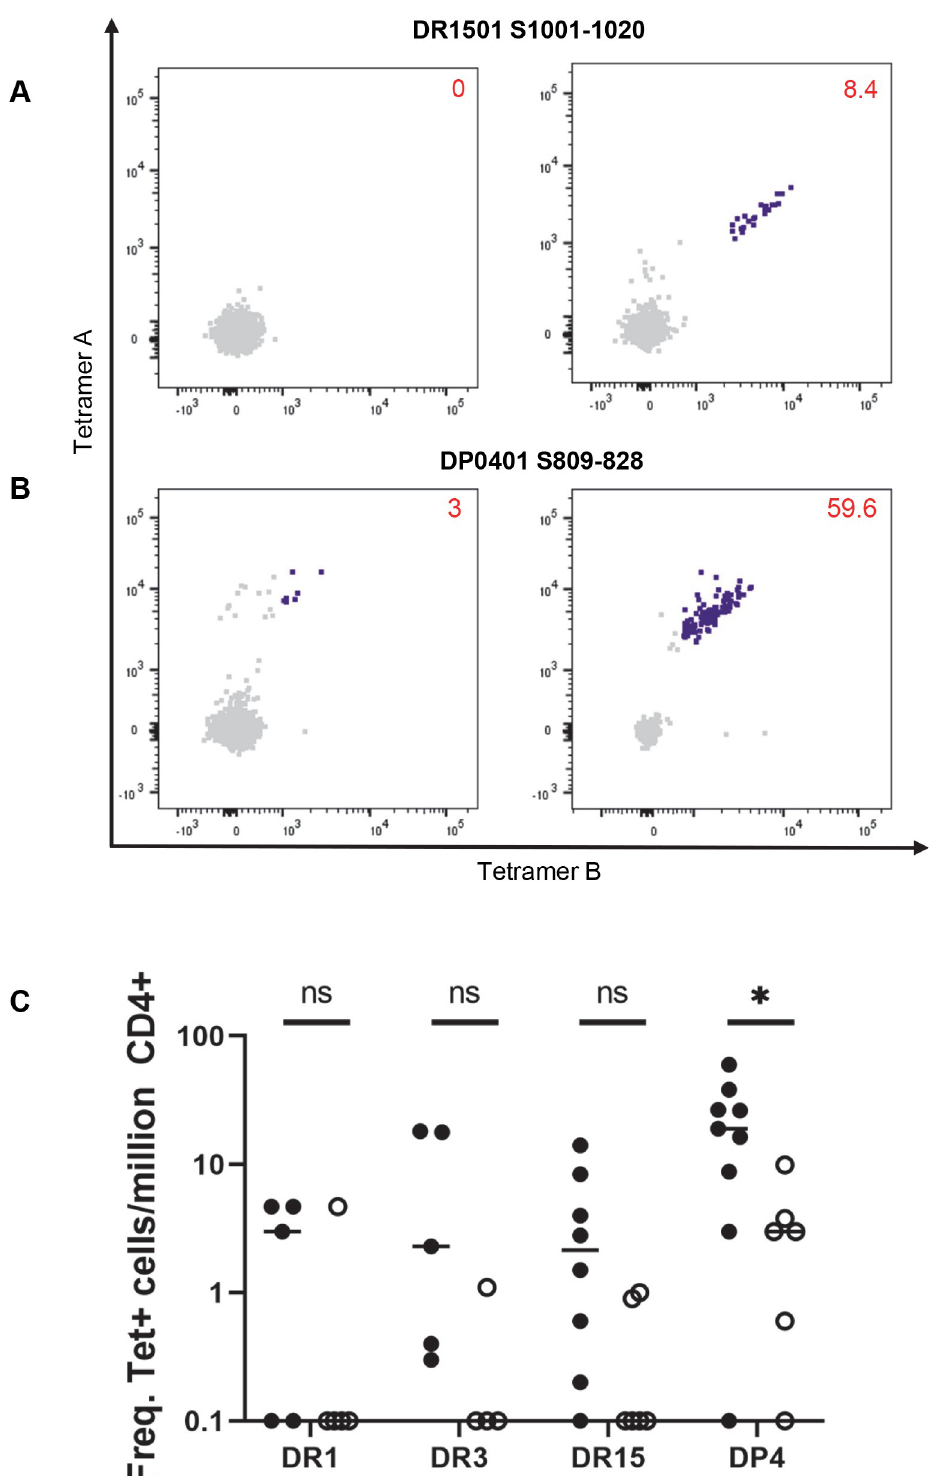
Fig 6. Frequencies of cross-reactive T cells. (A) Ex vivo staining of PBMC from DRB1501 individuals with tetramers. Representative FCS plots of PBMC from unexposed (left) and exposed (right) individuals stained with DR1501 SARS-CoV-2 S 1001-1020 -specific tetramers. Numbers indicate frequency of total tetramer positive cells per million CD4+ T cells. (B) Ex vivo staining of PBMC from DP0401 individuals with tetramers. Representative FCS plots of